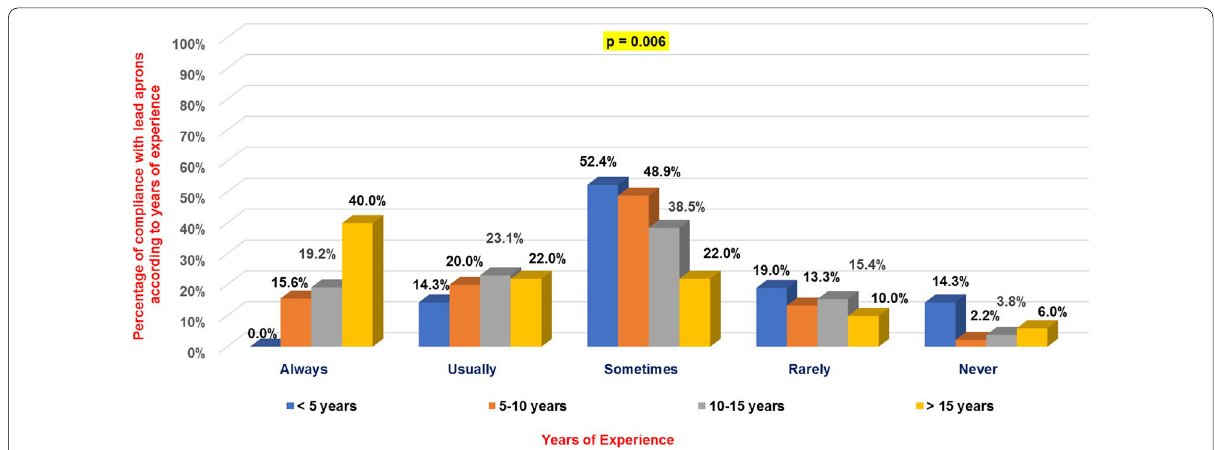
Fig. 2 Percentage of compliance with lead aprons according to the years of